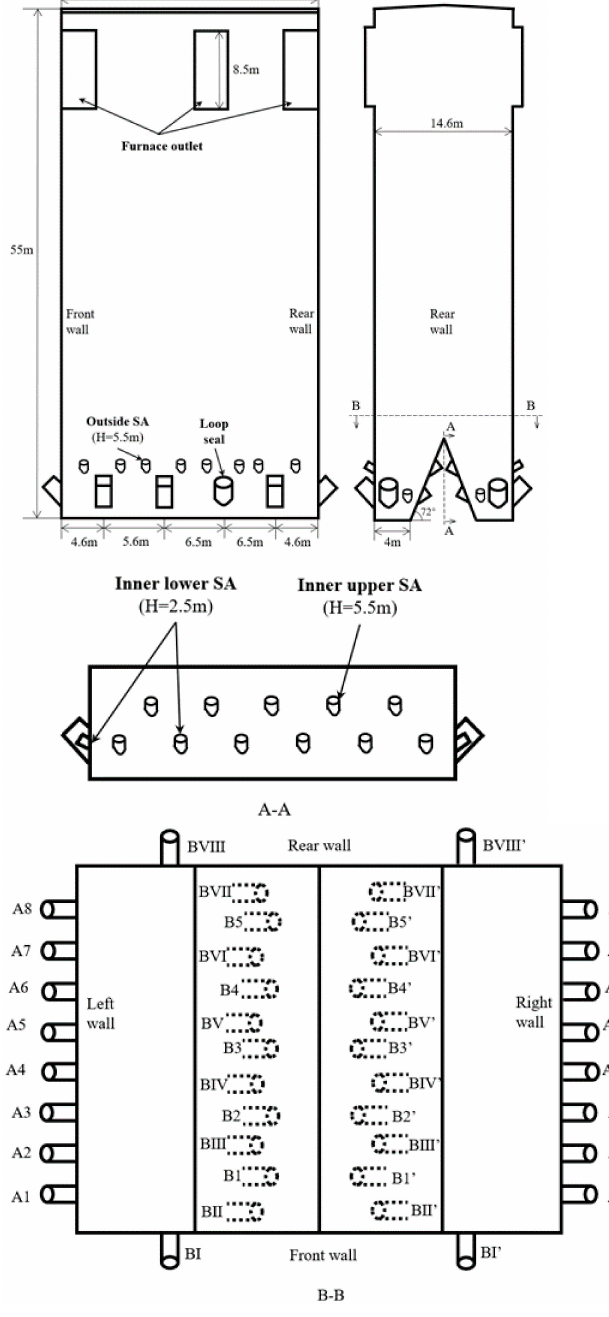
Figure 2. The body structure and the location of secondary air